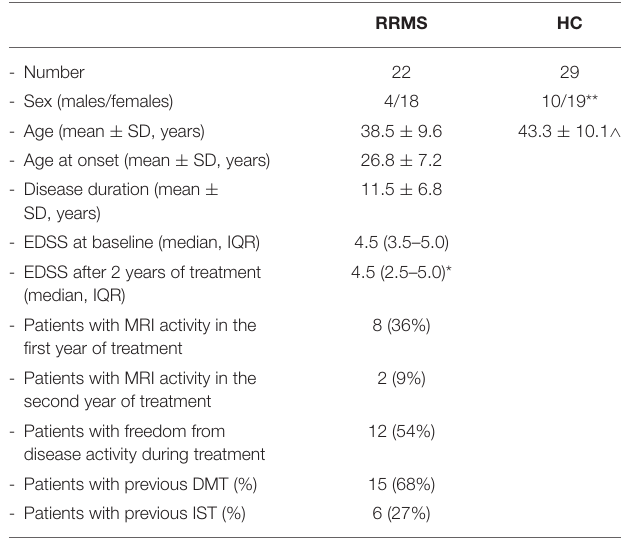
TABLE 1 | The demographic and clinical data of the relapsing remitting multiple sclerosis (RRMS) subjects and healthy controls (HCs) enrolled for this